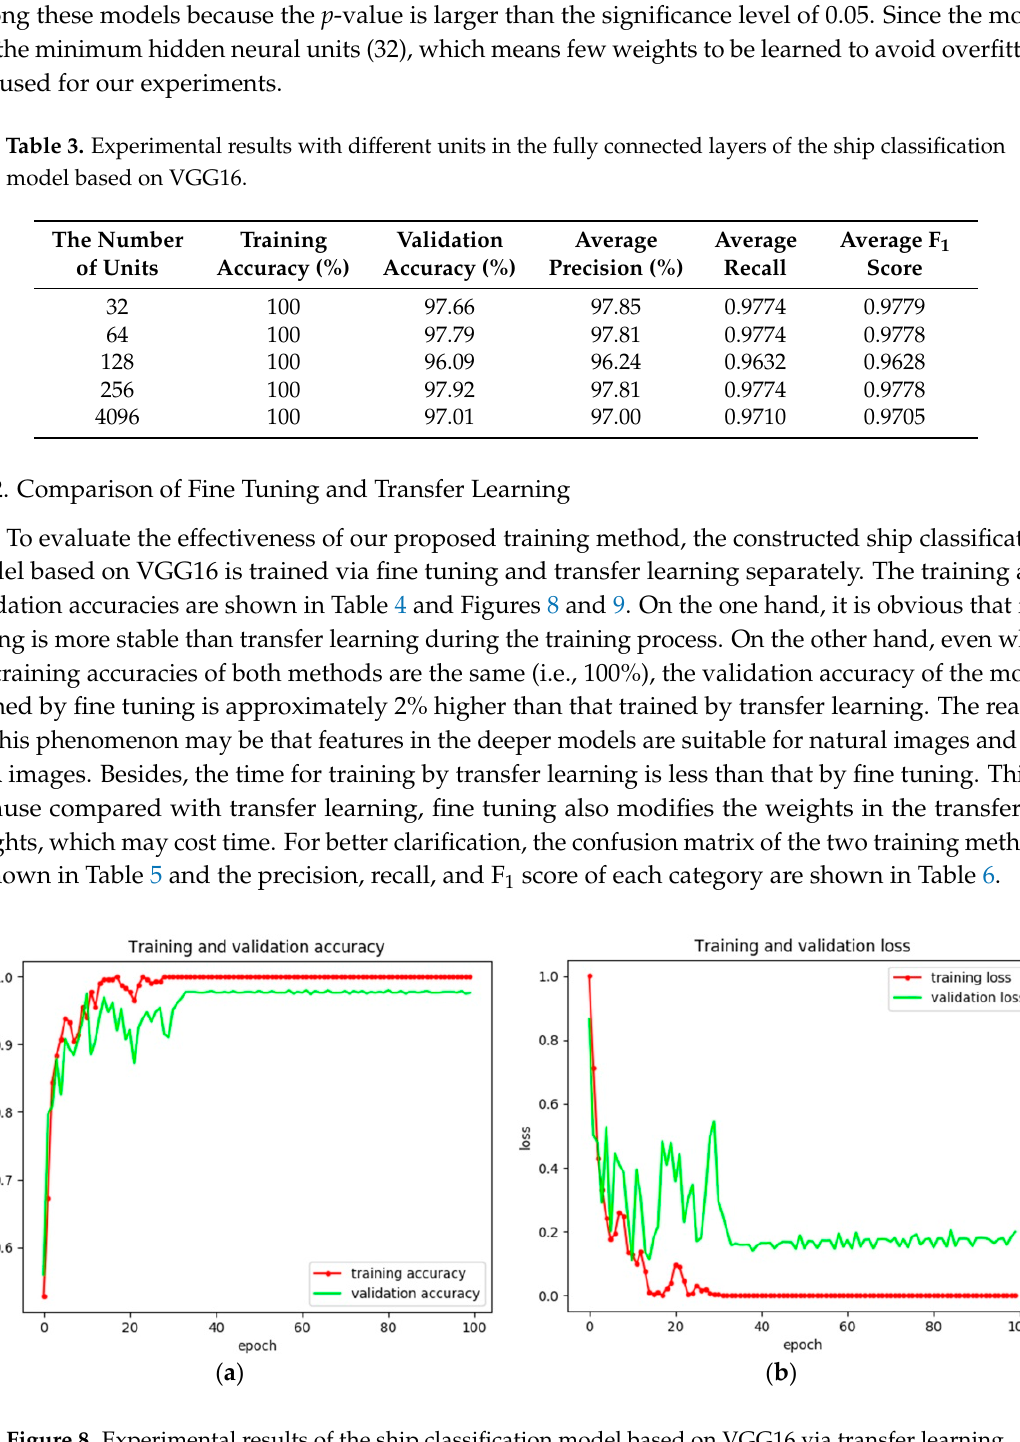
( b ) Figure 9. Experimental results of the ship classification model based on VGG16 via fine tuning. ( a ) Training and validation accuracy and ( b ) training and validation loss. McNemar’s test is also used and the contingency table is shown in Table 7. It is easy to obtain the fact that there is no significant difference between these two models. However, compared with the model trained via fine tuning, even the model via transfer learning can exactly classify oil tankers, but it failed to recognize the containers as shown in Table 5. Therefore, the precision, recall, and F 1 score of the model trained by fine tuning are higher than those trained by transfer learning. In